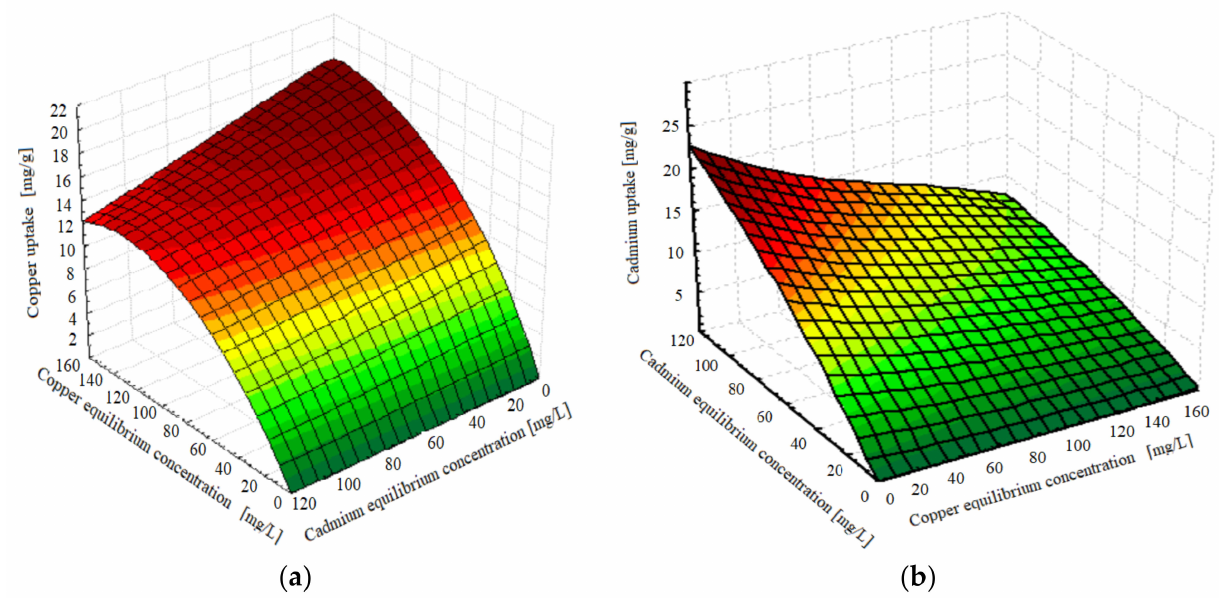
Figure 8. Effect of the equilibrium concentration of ( a ) Cd 2+ and ( b ) Cu 2+ on the multicomponent adsorption of copper (mass of adsorbent is 0.1 g, volume of solution is 50 mL, temperature is 25 ◦ C, and equilibrium time is 72